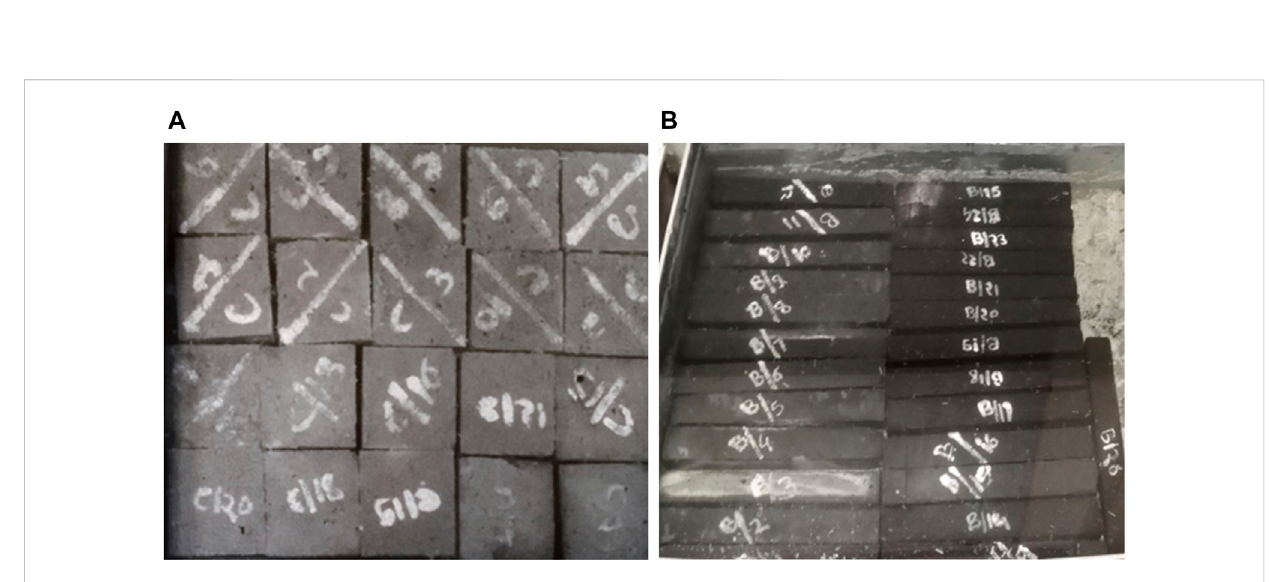
FIGURE 4 Curing of (A) cube specimen; (B) beam